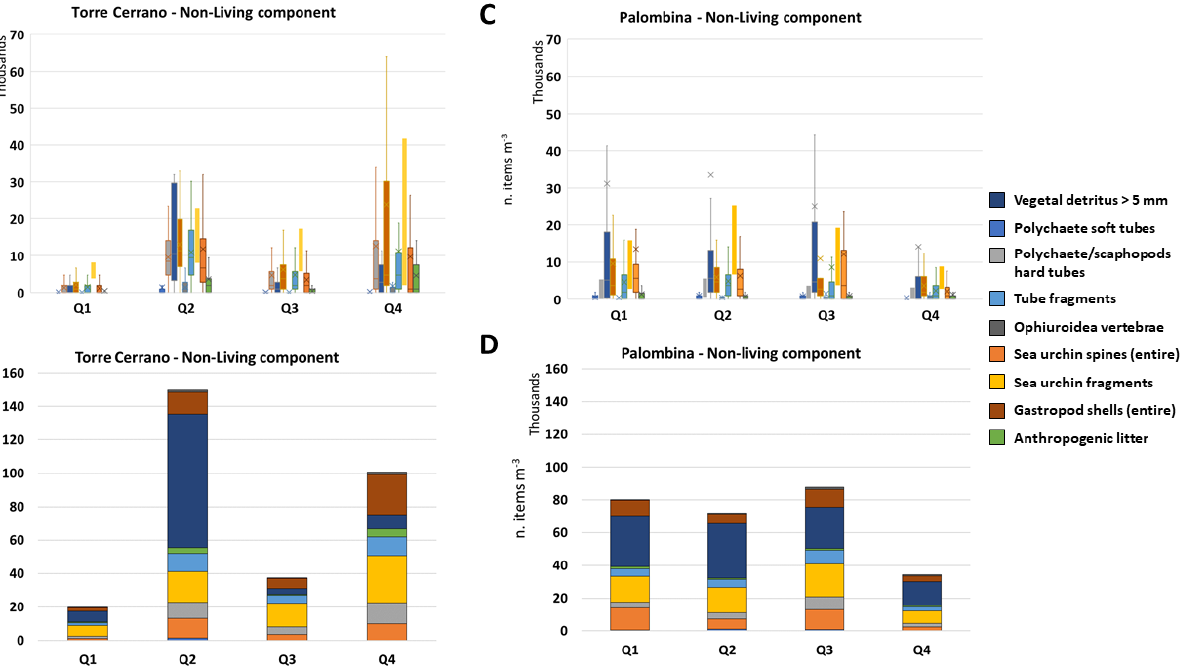
Figure 3. Temporal variations in abundance (n. items m − 3 ) of the non-living component in the sedi- A , B ) and Palombina ( C , D ). Outliers not ments collected in Torre Cerrano MPA ( A , B ) and Palombina ( C , D ). Outliers not shown. sediments collected in Torre Cerrano MPA (